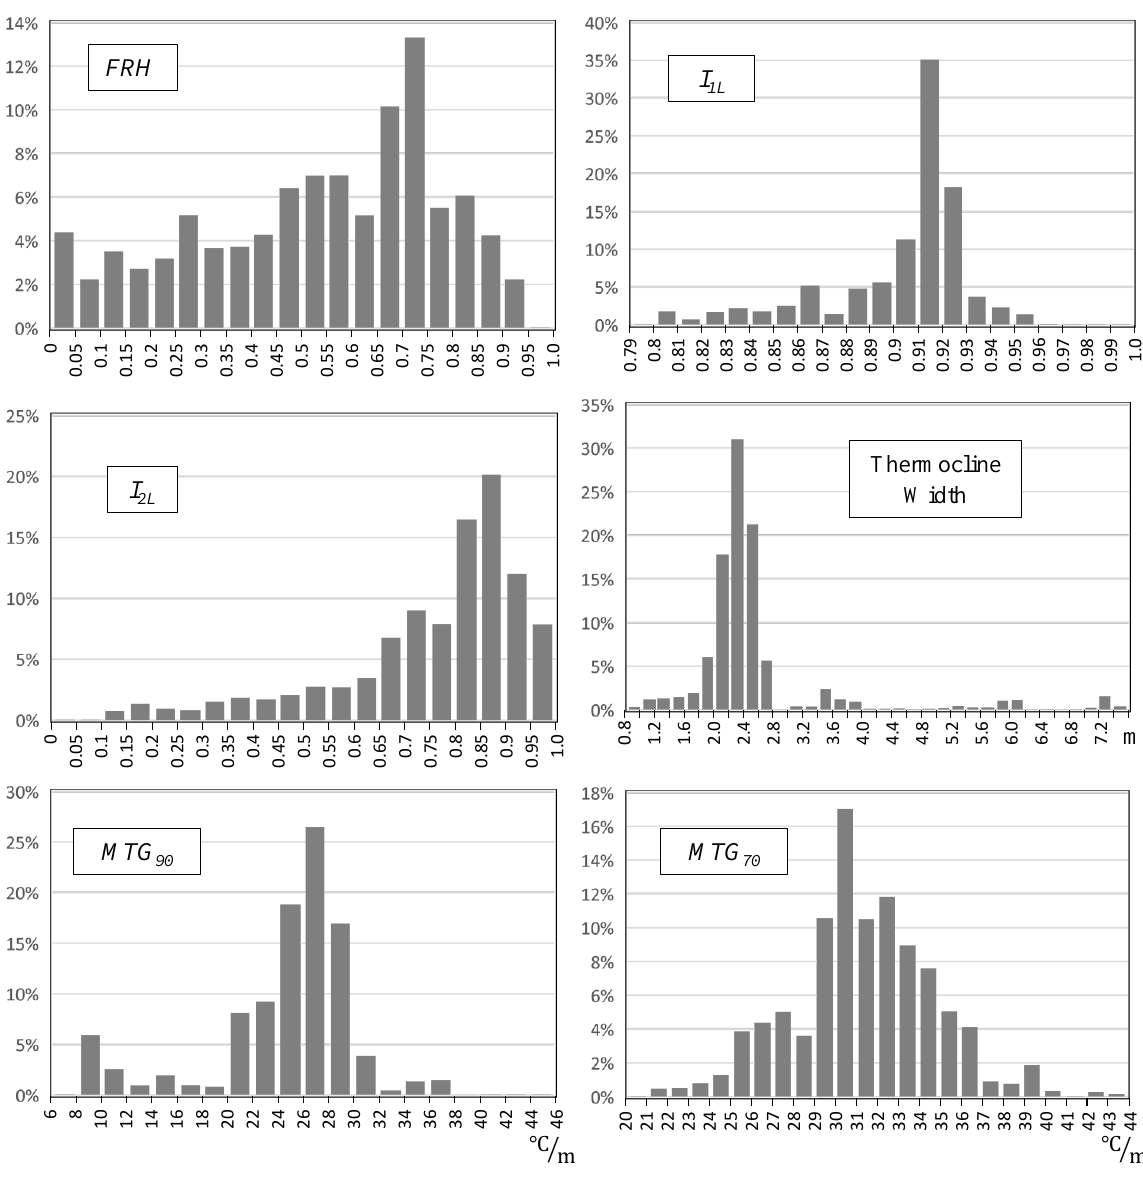
Figure 10. Discrete probability distribution of calculated parameters.